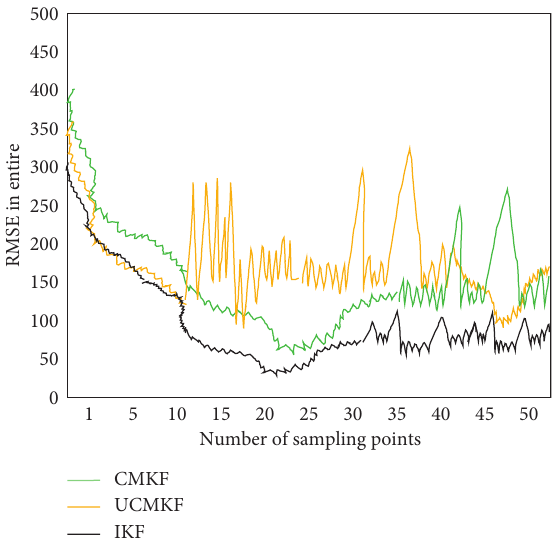
Figure 5: Position root mean square error